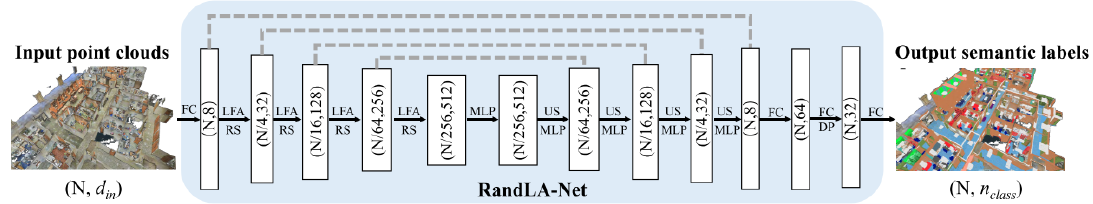
Figure 3. Overview of the RandLA-Net architecture (Hu et al., 2020). N indicates the number of input points. FC: Fully Connected layer, LFA: Local Feature Aggregation, RS: Random Sampling, MLP: shared Multi-Layer Perceptron, US: Up-sampling, DP: Dropout.